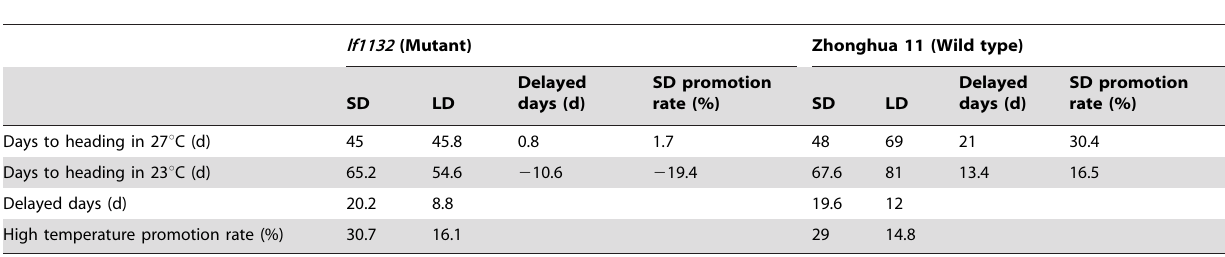
Table 1. The effect of different photoperiods and temperatures on heading-date.